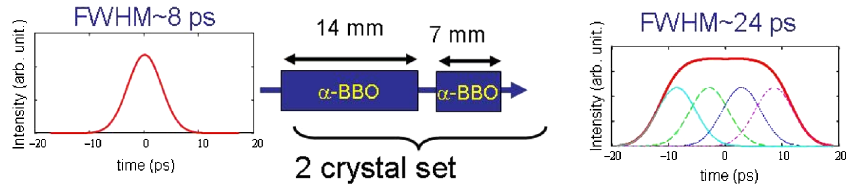
FIG. 4. Laser pulse stacking principle used during the experiment.